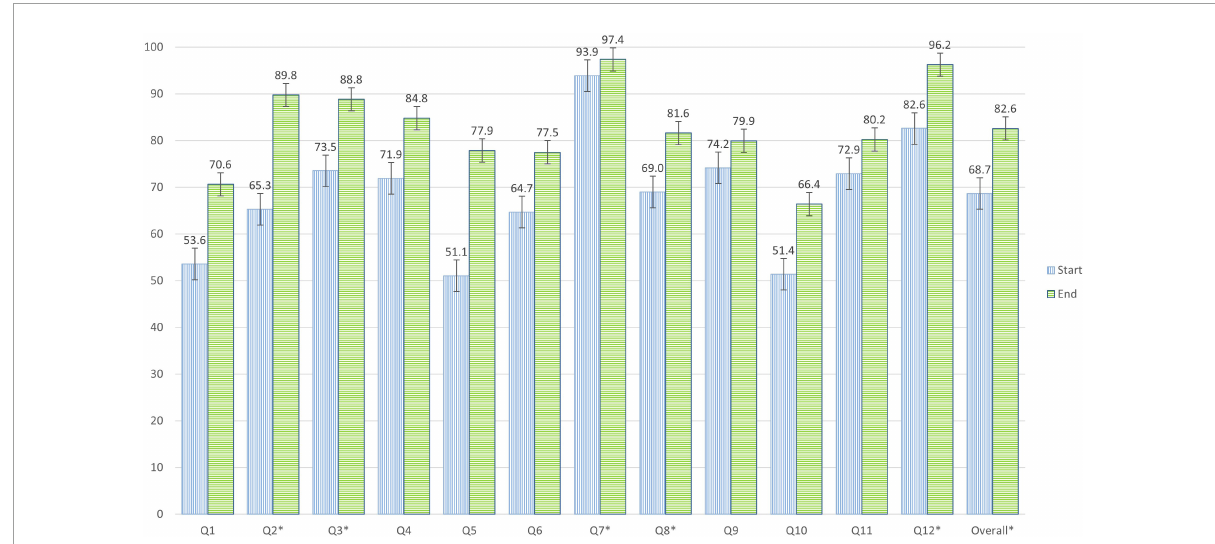
FIGURE1 Percentages of correct answers to the 12 questions of the survey carried out by pre-university students at the beginning and end of the SWICEU project during the 2017–2021 academic years. “*”Marks the questions with statistically significant differences.